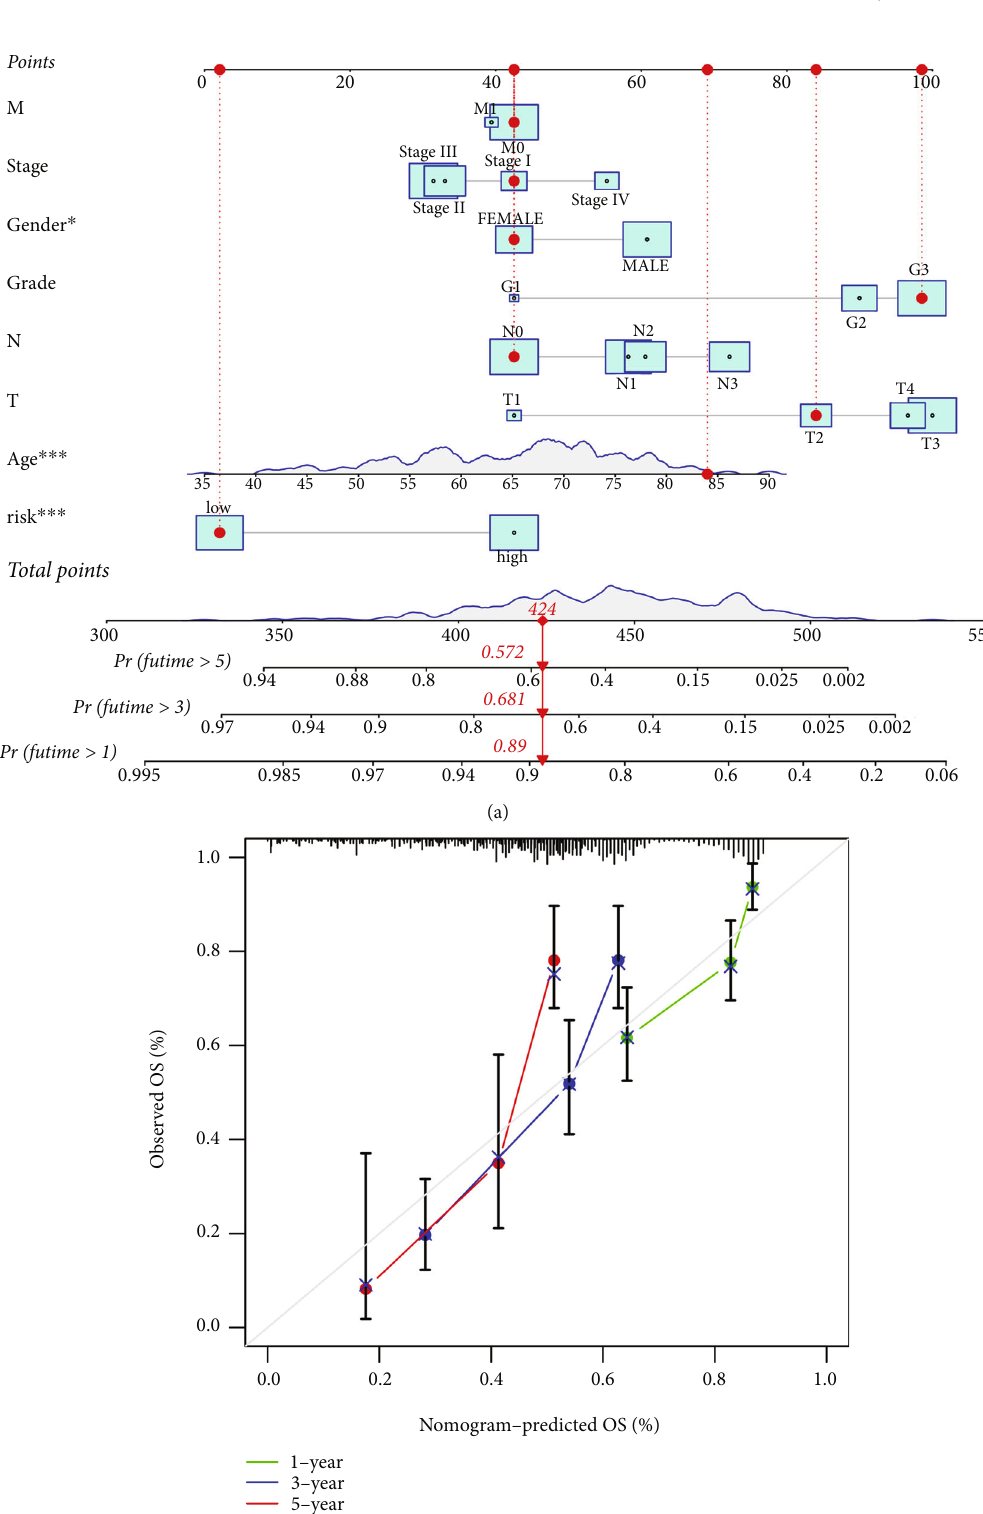
Figure 6: The nomogram of prognostic model. (a) A nomogram combining age, gender, pathological grade, stage, tumor stage, node stage, metastasis stage, and risk score that predicts the 1-, 3-, and 5-year prognoses of clear cell renal cell carcinoma patients. (b) The 1-, 3-, and 5- year calibration curves for the